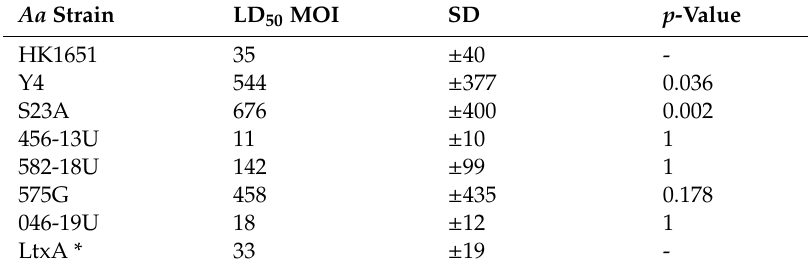
Table 3. The number of A. actinomycetemcomitans ( Aa ) cells / THP-1 cell (MOI) that killed 50% of the target cells after 2 h exposure (LD 50 ). The viability of the exposed THP-1 cells was examined with quantitative neutral red uptake. Mean ± SD of five experiments are shown. p -value vs. HK1651 is indicated. Aa Strain LD 50 MOI SD p -Value HK1651 35 ± 40